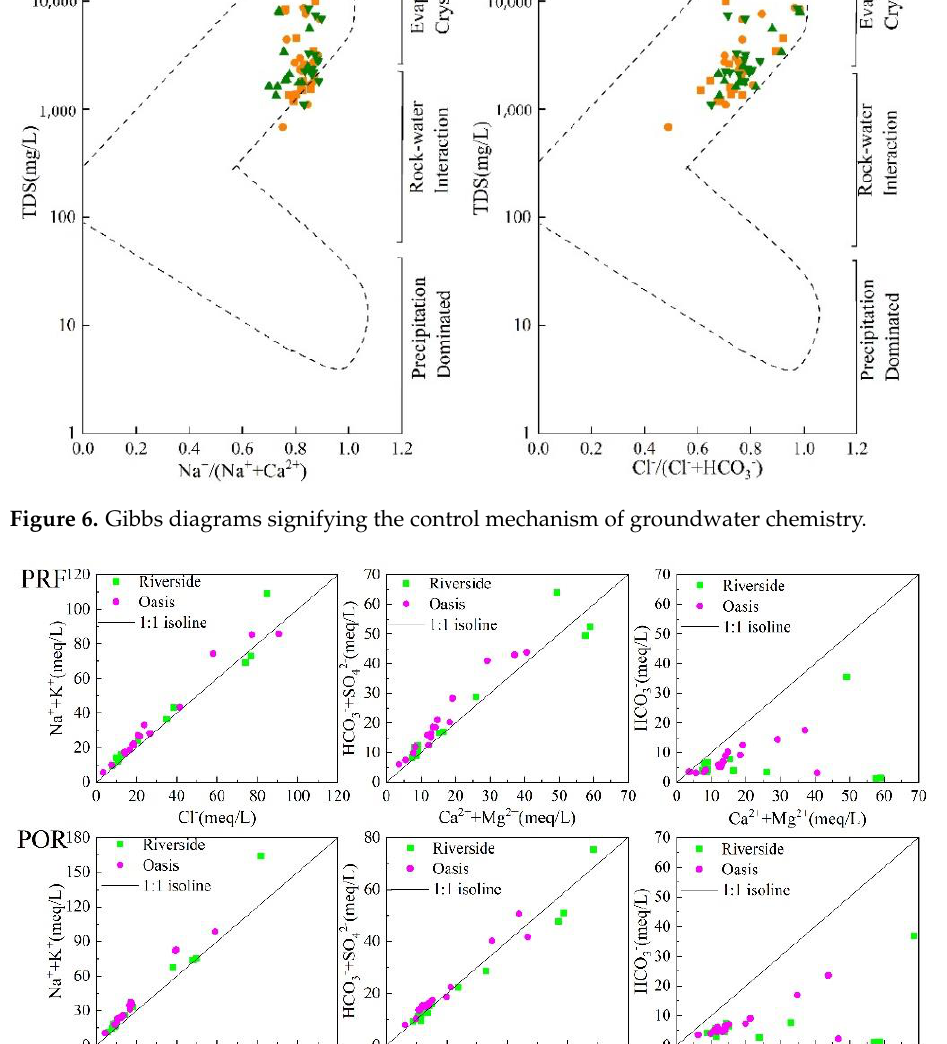
Figure 6. Gibbs diagrams signifying the control mechanism of groundwater chemistry.